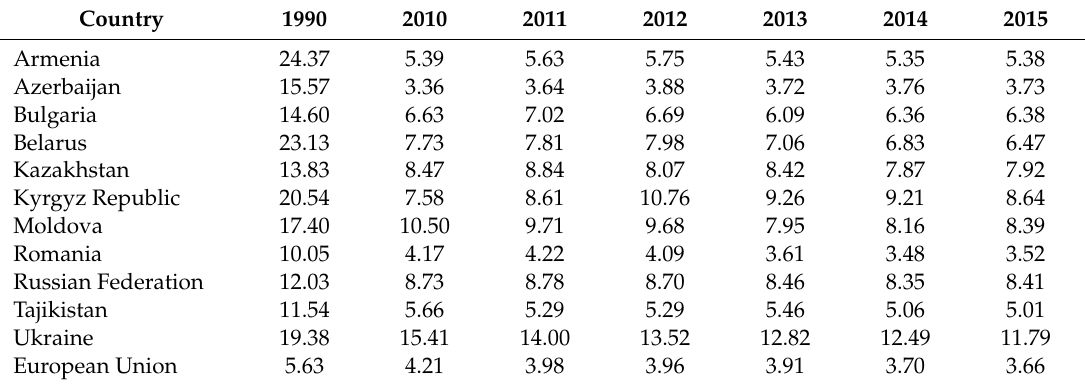
Table 3. Energy intensity level of primary energy, MJ / $2011 PPP